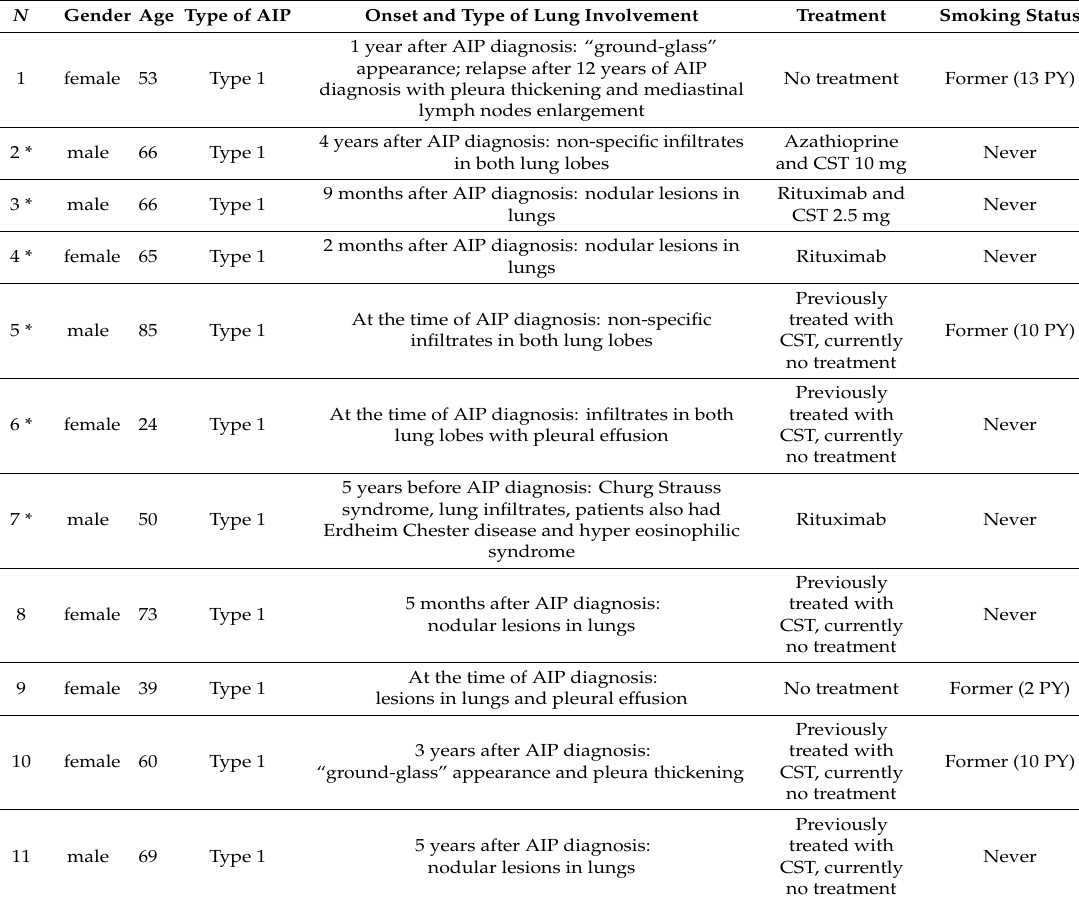
Table 2. Demographic and clinical features of patients with AIP type 1 and lung involvement.